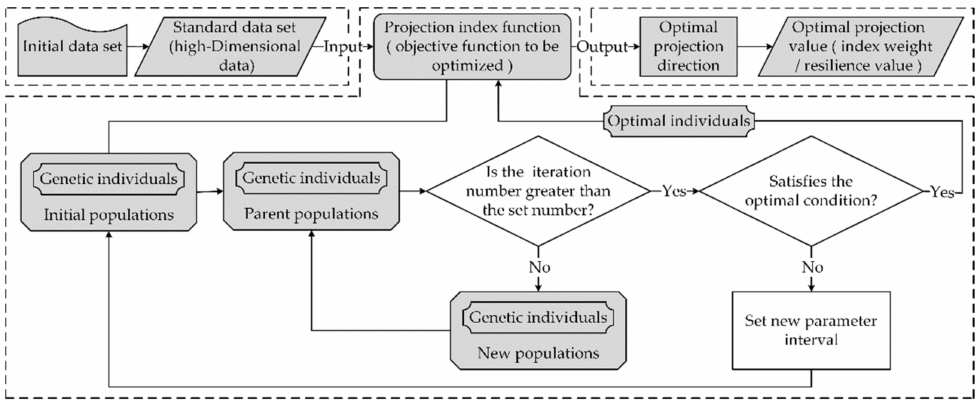
Figure 3. Technology roadmap of